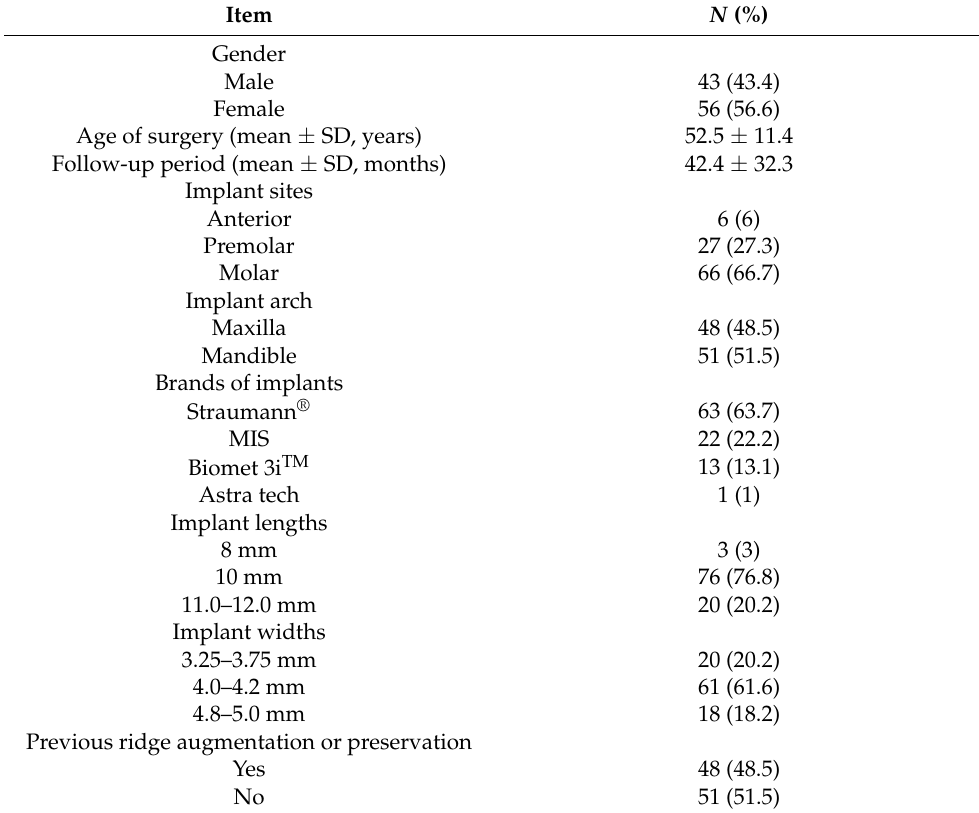
Table 1. Demographic data of enrolled patients and dental